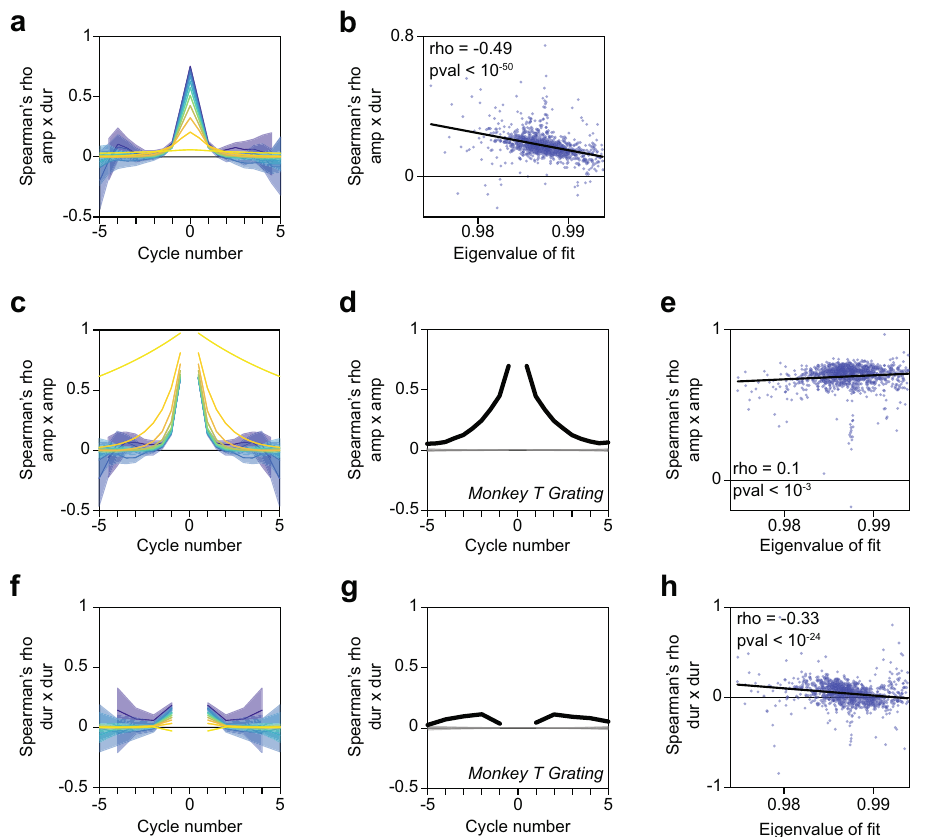
Fig. 9 A damped harmonic oscillator reproduces gamma-cycle amplitude and duration cross- and auto-correlations in the LFP. a Correlation between the amplitude of a gamma half-cycle and the duration of 10 gamma half-cycles before and after it. These correlation coef fi cients were computed for synthetic signals generated from AR(2) processes with corresponding eigenvalue magnitudes ranging from 0.9 (dark blue) to 0.999 (bright yellow) in steps of approximately 0.01. The error regions show ±2 SEM based on a bootstrap procedure. b Scatter plot of the eigenvalue magnitudes displayed in Fig. 8c and the instantaneous correlation between gamma half-cycle amplitude and duration from the corresponding LFP data. The regression fi t (black line) was computed with the least-squares method. c The correlation between the amplitude of a given gamma half-cycle and the 10 gamma half-cycles before and after it (i.e. the autocorrelation) for synthetic signals generated from AR(2) processes. The error regions show ±2 SEM based on a bootstrap procedure. d The autocorrelation for LFP data from monkey T during presentation of a full-screen drifting grating. The gray lines and gray-shaded areas depict the means and 99.9% con fi dence regions, after randomizing the order of duration values across trials. e Same as b , but now showing the correlation between the amplitude of a given gamma half- cycle and the amplitude of its preceding and succeeding half-cycle, pooling data points from multiple datasets, conditions, and channels. f – h Same as c – f but for gamma full-cycle durations. Source data are provided in the Source Data fi